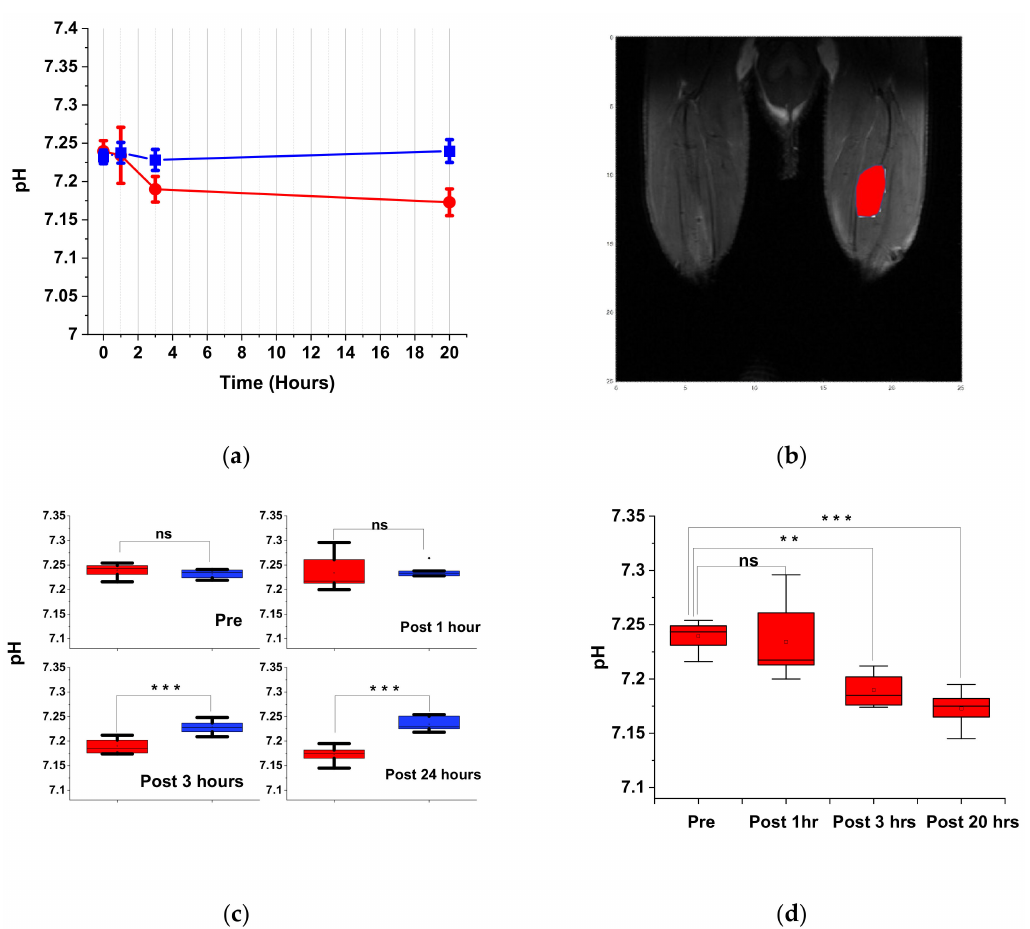
Figure 4. ( a ) Time-dependent pH variation in CEST images by region of interest (ROI) analysis of gastrocnemius muscle region. The ROI is shown in ( b ). The pH of the electrical stimulation group ( • ) and control group ( (cid:4) ) by ROI analysis through time. The 0-h data in the electrical stimulation group refer to the readings taken before electrical stimulation. The deviation between 0-h data in the electrical stimulation and control group may be due to the influence of implanted electrodes (tungsten wires). ( c ) The mean, maximum, and minimum plots of pH of electrical stimulation (green) and control group (red) with di ff erent times. A t -test was utilized to test statistical significance of the di ff erence in means. The di ff erences between the electrical stimulation and control group at 3-h and 20-h post-stimulation data are significant (*** p < 0.001). ( d ) A similar plot showing the pH of